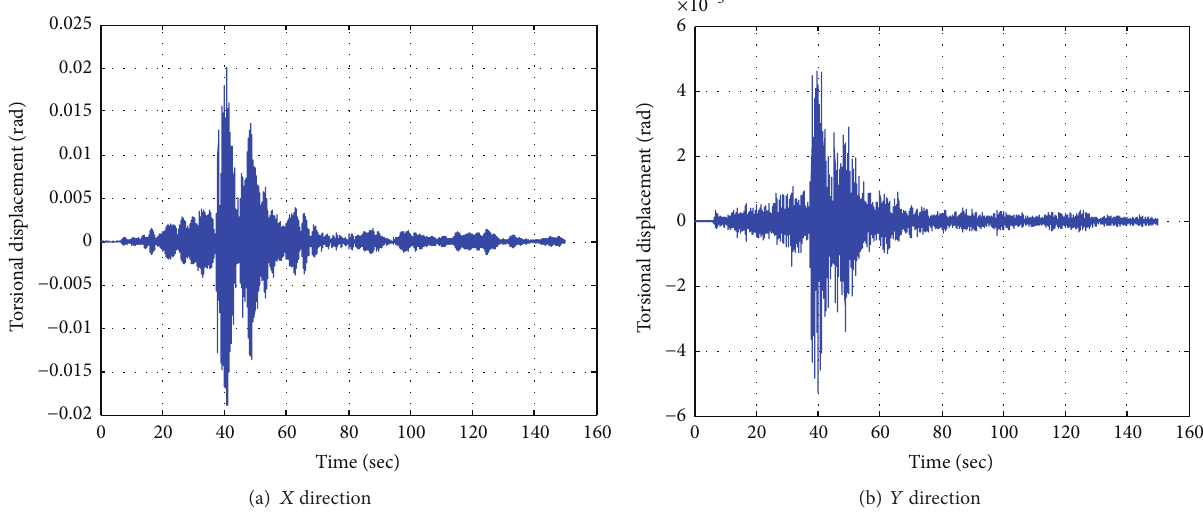
Figure 11: Torsional deformation of the building during shaking.